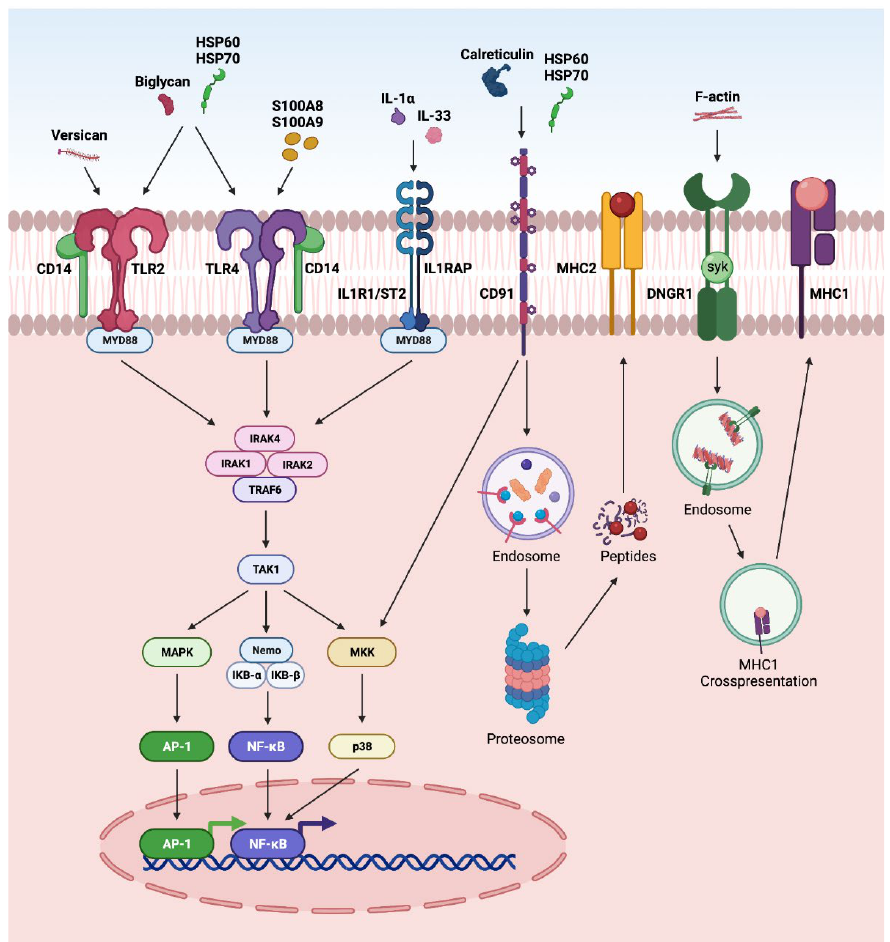
Figure 4. Overview of DAMPS activating other pathways: (a) In CD14-dependent pathway,